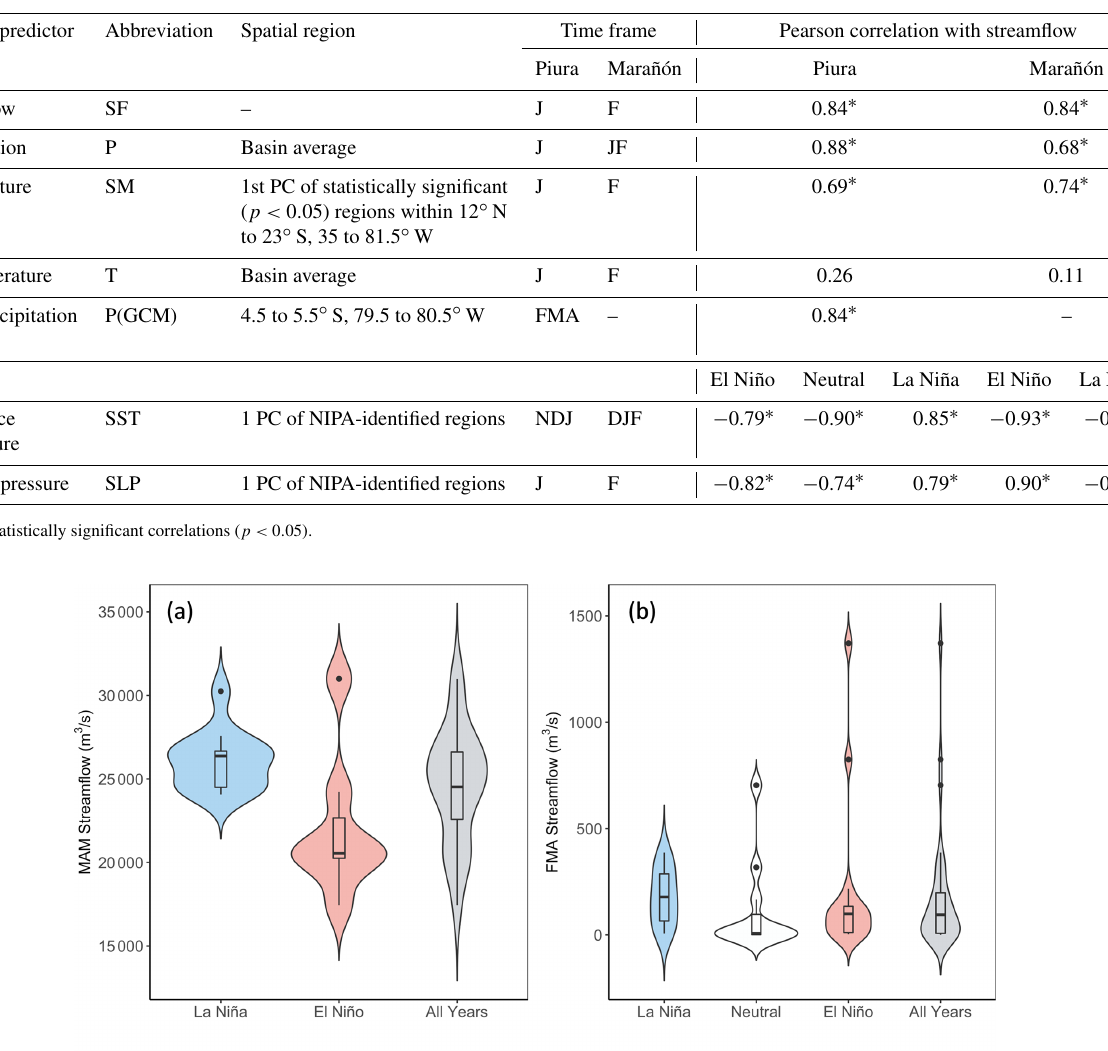
Table 2. The suite of potential predictor variables for the statistical forecast model and their Pearson correlation coefficient with FMA streamflow at Piura at Puente Sánchez Cerro and MAM streamflow at Marañón at San Regis. SST and SLP predictor spatial extents are determined by NIPA (Fig. 3) and correlations are presented by phase. J (F) indicates January (February).